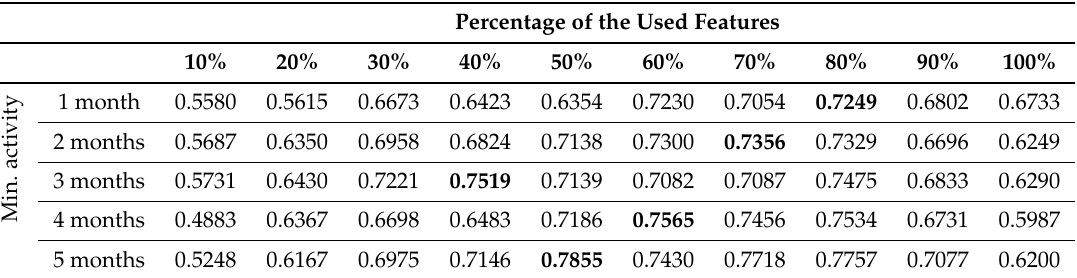
Table A14. F-score macro average for the SVM classification of two levels of the hierarchy in the Enron dataset. The values which are bolded are the best results for a given minimum communication activity.